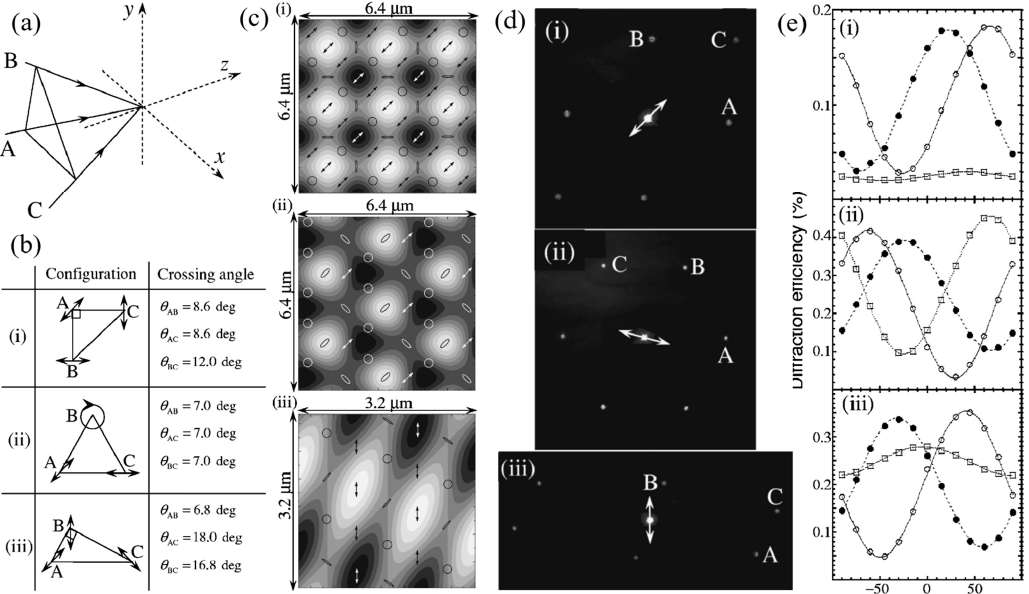
Figure 8. ( a ) Arrangement and ( b ) polarization configurations of three interference beams: case i, case ii and case iii. ( c ) Simulated intensity and polarization states of the three cases. ( d ) Experimental diffraction patterns of the three cases. ( e ) Diffraction efficiency of spot A (open circles), B (filled circles) and C (open squares) as a function of azimuth polarization of the LP probing beam. Reproduced from Reference [45] with permission from AIP Publishing.